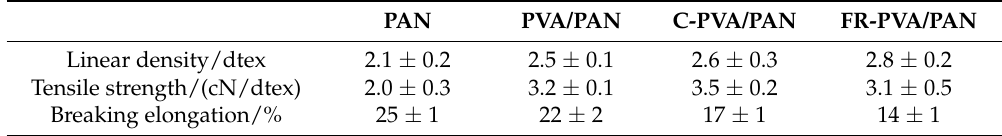
Table 1. Mechanical properties of different